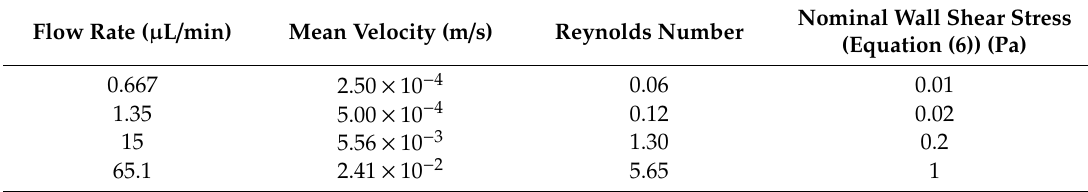
Table 2. Hydrodynamic